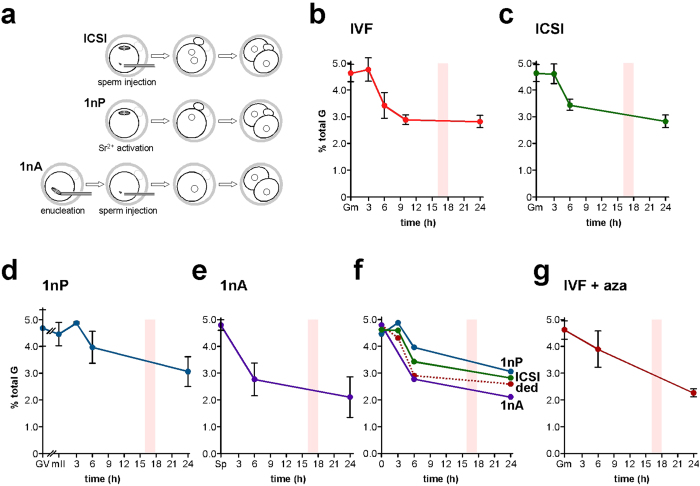
5 mC profiles determined by SMM in mouse embryos produced by in vitro fertilization and different types of micromanipulation.(a) Schematic representation of three of the principal types of manipulation used to generate embryos: intracytoplasmic sperm injection (ICSI), parthenogenesis (1nP) and androgenesis (1nA). (b) Levels of 5 mC determined by SMM and expressed as a percentage of total G-residues in embryos at the times shown (h) after activation of development following in vitro fertilization (IVF). (c) 5 mC levels as per (b) except that embryos were generated by ICSI, (d) parthenogenesis (1nP), or (e) androgenesis (1nA). (f) Composite of panels (c–e) showing deduced values (ded) for 5 mC levels in androgenotes. Model 1 (Supplementary Fig. S4) was used to produce the estimated 1nA values but models 1 and 2 gave similar results. mII, metaphase II oocyte; Sp, cauda epididymidal sperm. (g) 5 mC levels as per panel (b), except that IVF was performed in the presence of the DNA methyl-transferase inhibitor, 5-aza-2′deoxycytidine (azaC). A bar in each histogram marks the approximate time of the first cell division. The zero time-point shows values for mII oocytes in (d,f) and the average of mII oocytes plus sperm for (b,c,f,g) and sperm for (e). Mean values are ±sd. Embryo numbers per analysis are given in Supplementary Table S1.